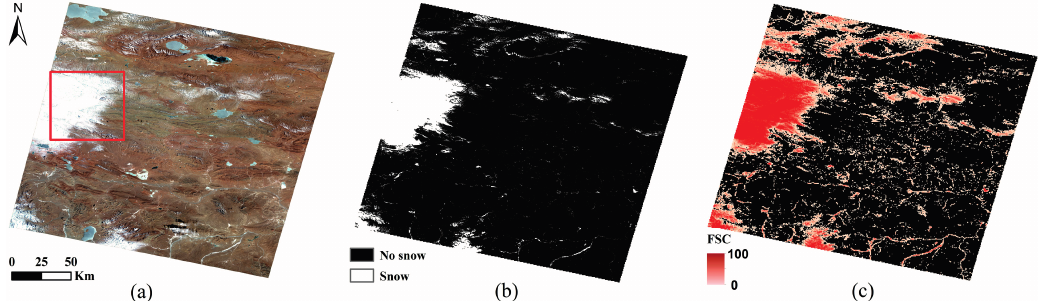
Figure 2. True color composite image ( a ), binary snow map ( b ) and fractional snow map ( c ) of OLI on 16 January 2014 in Tibetan